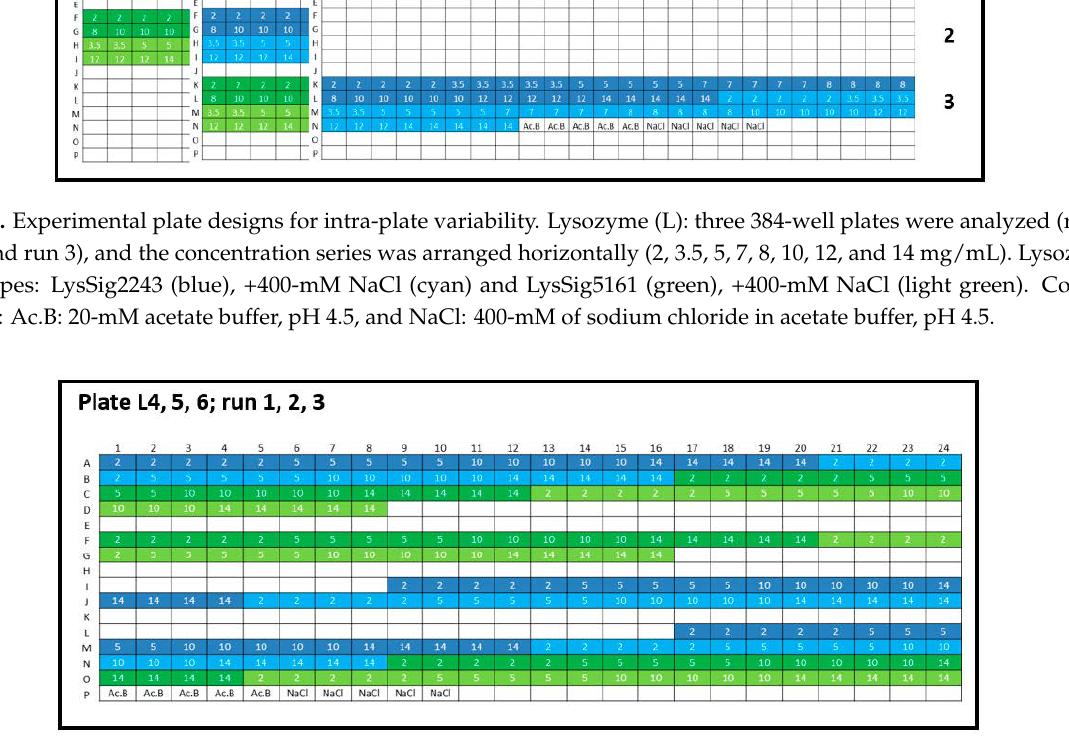
Figure 2. Experimental plate design for inter-plate variability. Lysozyme (L): three 384-well plates were analyzed (run 1, run 2, and run 3), and the concentration series was arranged horizontally (2, 5, 10, and 14 mg/mL). Lysozyme batch types: LysSig2243 (blue), +400-mM NaCl (cyan) and LysSig5161 (green), +400-mM NaCl (light green). Control samples were placed in row P: Ac.B: 20-mM acetate buffer, pH 4.5, and NaCl: 400-mM of sodium chloride in acetate buffer, pH